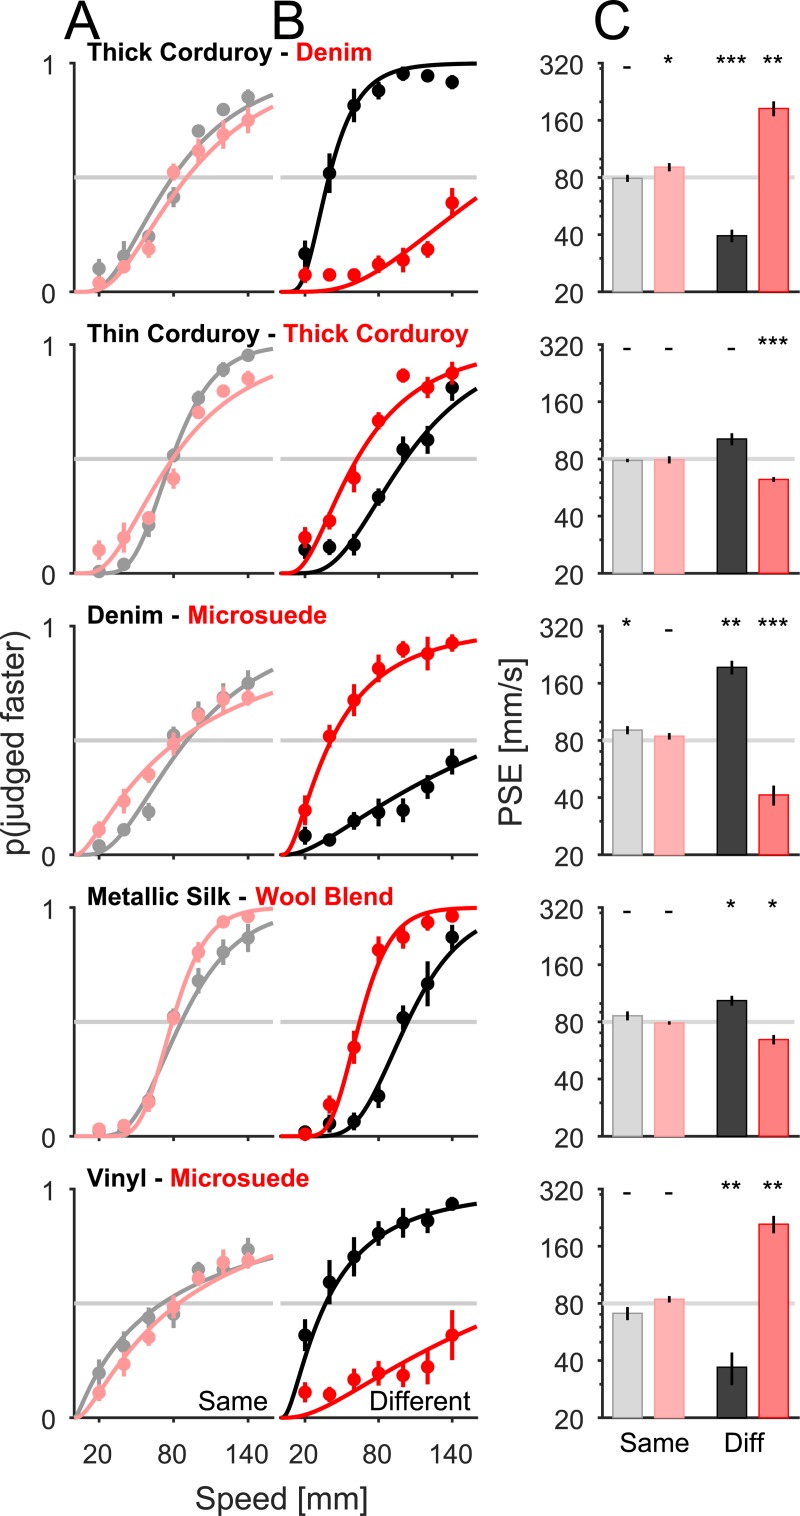
Speed discrimination across textures.(A, B) Discrimination performance—as gauged by the proportion of trials on which the comparison was judged to be faster than the reference versus speed—averaged across subjects for each texture pair. In (A), the reference and comparison were the same texture (reproduced from Fig 2, but organized by pairs). In (B), the reference and comparison were different textures. The color (black or red) depicts the texture used as reference. (C) PSE for the same (left, light) and different (right, dark) texture pairs. Error bars denote the SEM (n = 8 for each same pair, n = 9 subjects for each different pair). Stars reflect the outcome of a one-sample t test versus 80 mm/s (− denotes not significant, *p < 0.05, **p < 0.01, ***p < 0.001). The effect of texture on PSE was consistent with the results from the magnitude estimation experiment (Fig 1C, intercepts). Data underlying this figure can be found in S1 Data. PSE, point of subjective equality.